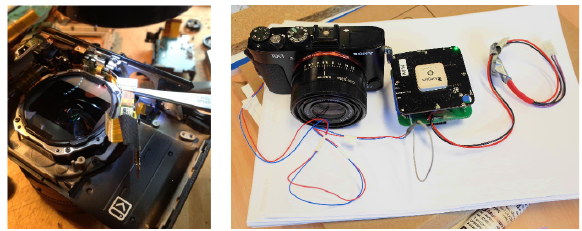
Figure 7: Adapting camera triggering with GPS module pulse © LOEMI